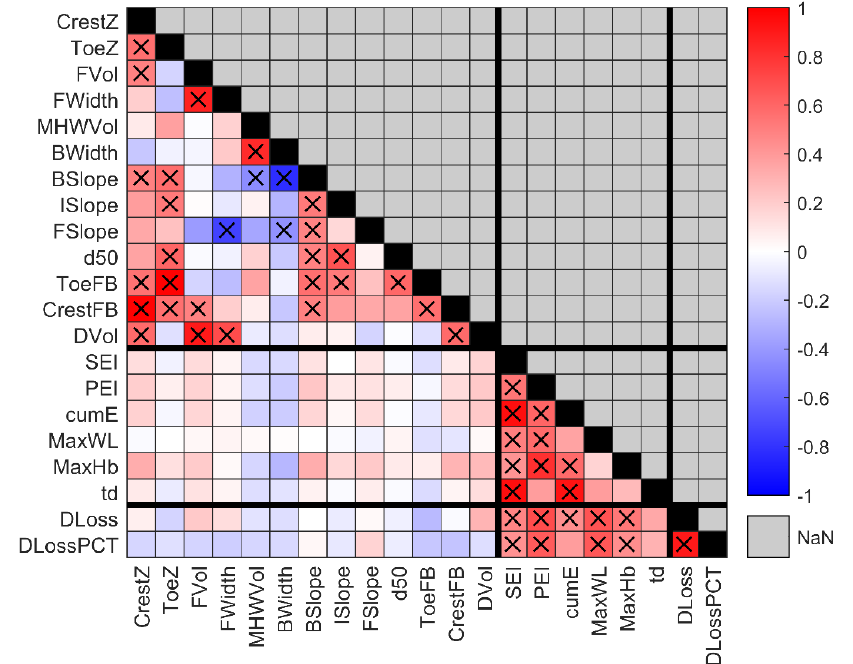
Figure 5. Spearman rank correlations between all predictor and impact variables. Black “X” markers indicate correlations of | ρ | > 0.4 and p < 0.05. Figure adapted from Beuzen et al. [19].